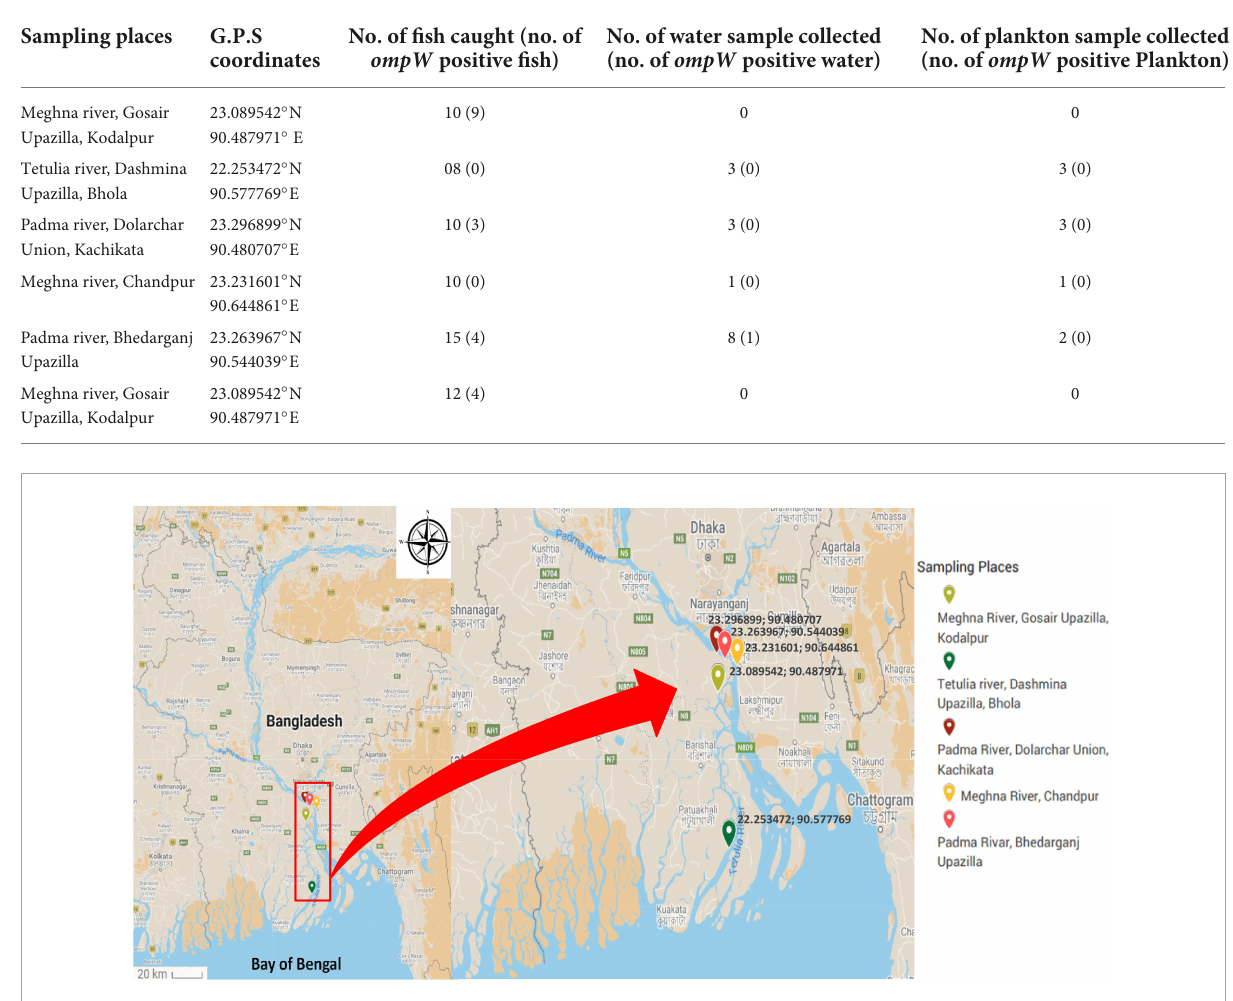
FIGURE1 Map showing the sampling site of freshly caught Hilsha fish.